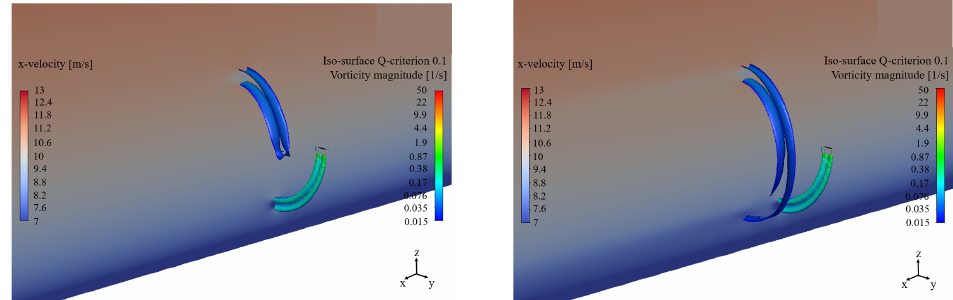
Figure 14. Visualization of the wake after ( left ) the first loop and ( right ) the last loop for the crosswind flight with logarithmic inflow. Note that the flow is from right to left. From the contour plot of the x-velocity, the logarithmic profile is clearly visible, but this is disturbed when the aircraft wing passes through this plane due to induced flow. From the flow field after the last loop, it can be seen that there is a velocity deficit in the downstream direction.